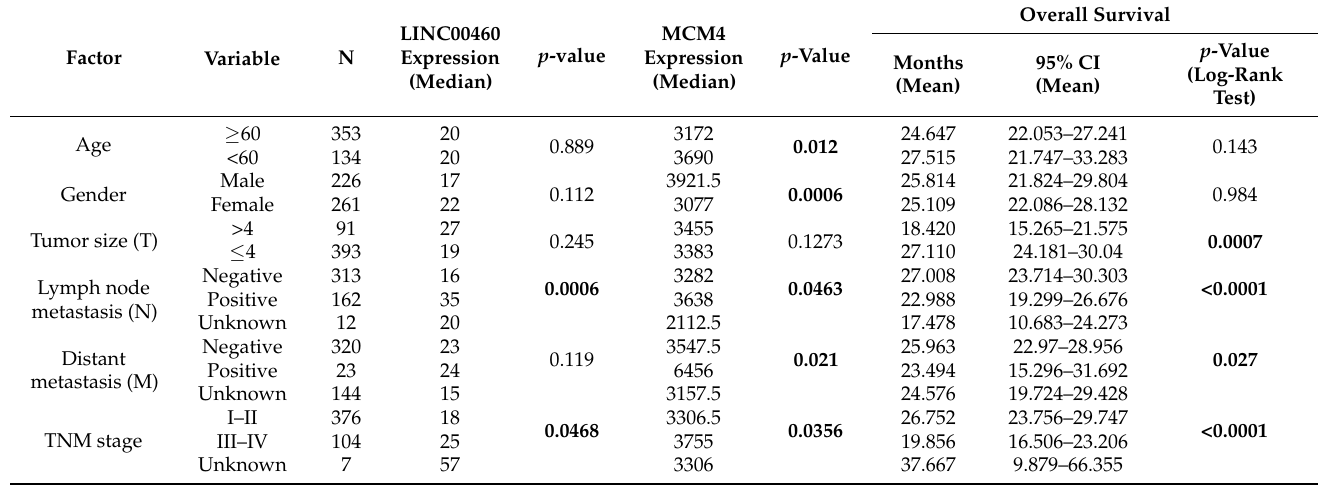
Table 1. Univariate analysis of overall survival in LUAD patients stratified based on clinical charac-